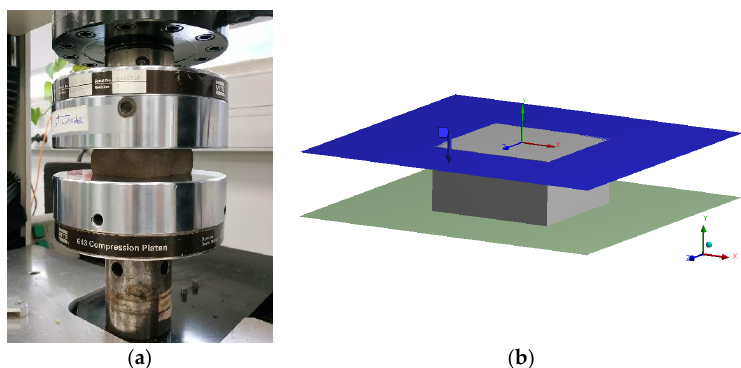
Figure 3. Compression of a cork–rubber sample: ( a ) Experimental setup; ( b ) Finite element model.